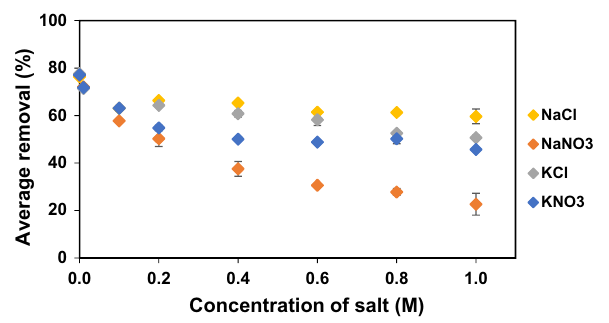
Fig. 3 The effect of ionic strength on the adsorption of 100 mg L −1